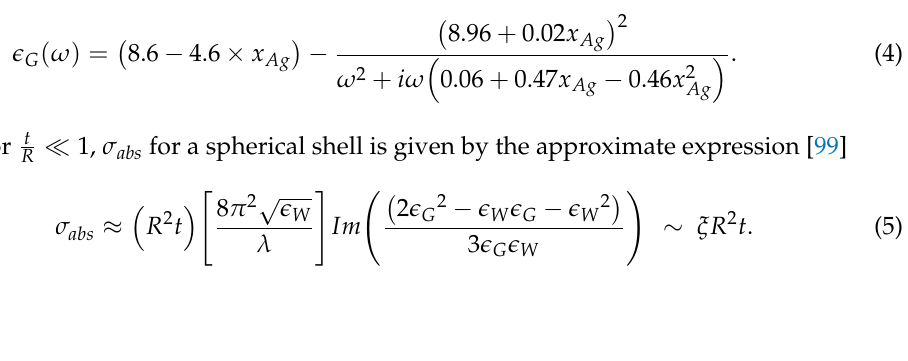
Figure 8. ( A ) Schematic diagram of gold nanoparticles nucleating on the liposome surface. ( B ) TEM image of liposome decorated with gold nanoparticles. Adapted from [46,47], published by Wiley, 2017 and Wiley, 2020.